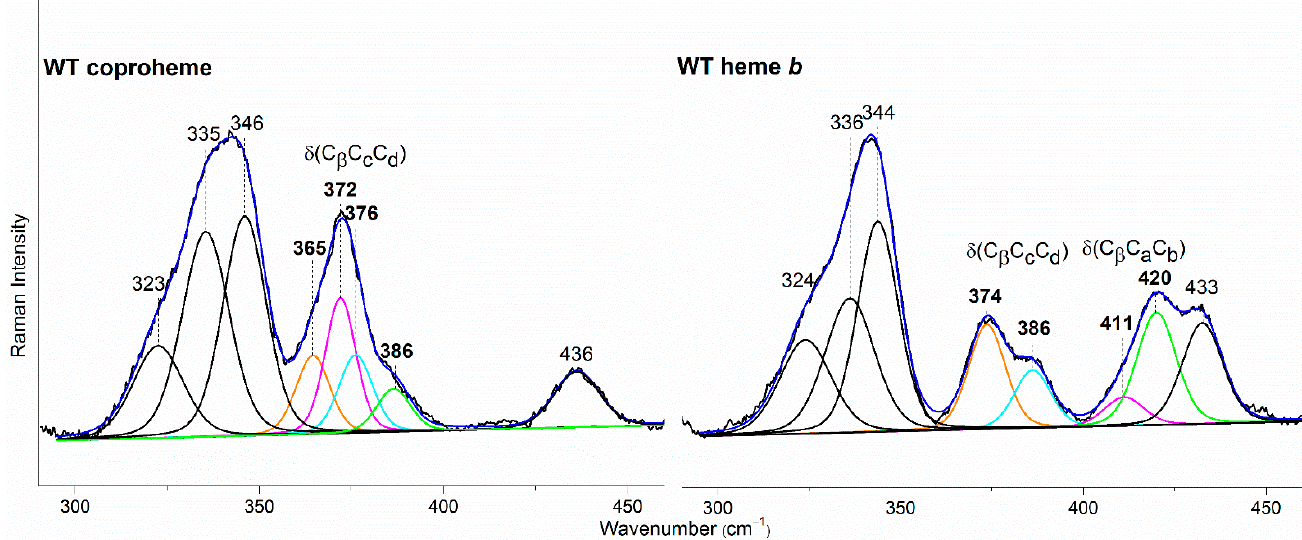
Figure 8. Curve-fitting analysis of the RR spectra of Cd ChdC WT in complex with coproheme ( Left ) and heme b ( Right ). The bands indicated in black at 323, 335, 346, and 436 cm − 1 in the coproheme complex and at 324, 336, 344, and 433 cm − 1 in the heme b complex, are assigned to the ν 17 , γ 6, ν 8 , and γ 22 / δ (C β -Me) porphyrin modes, respectively, according to Refs. [32–34]. In the WT coproheme complex, the bands indicated in bold at 365, 372, 376, and 386 cm − 1 are assigned to p7 (orange), p2 (magenta), p6 (cyan), and p4 (green) propionate bending modes (see text), respectively. In the WT heme b complex the bands indicated in bold at 374 and 386 cm − 1 are assigned to p7 (orange) and p6, (cyan) respectively, while the bands at 411 and 420 cm − 1 are assigned to the vinyl bending modes in position v2 (magenta) and v4 (green), respectively [10,11]. The corresponding bandwidths are 11 and 13 cm − 1 for the propionate and vinyl bending modes, respectively, while they are within the 13–17 cm − 1 range for the other porphyrin